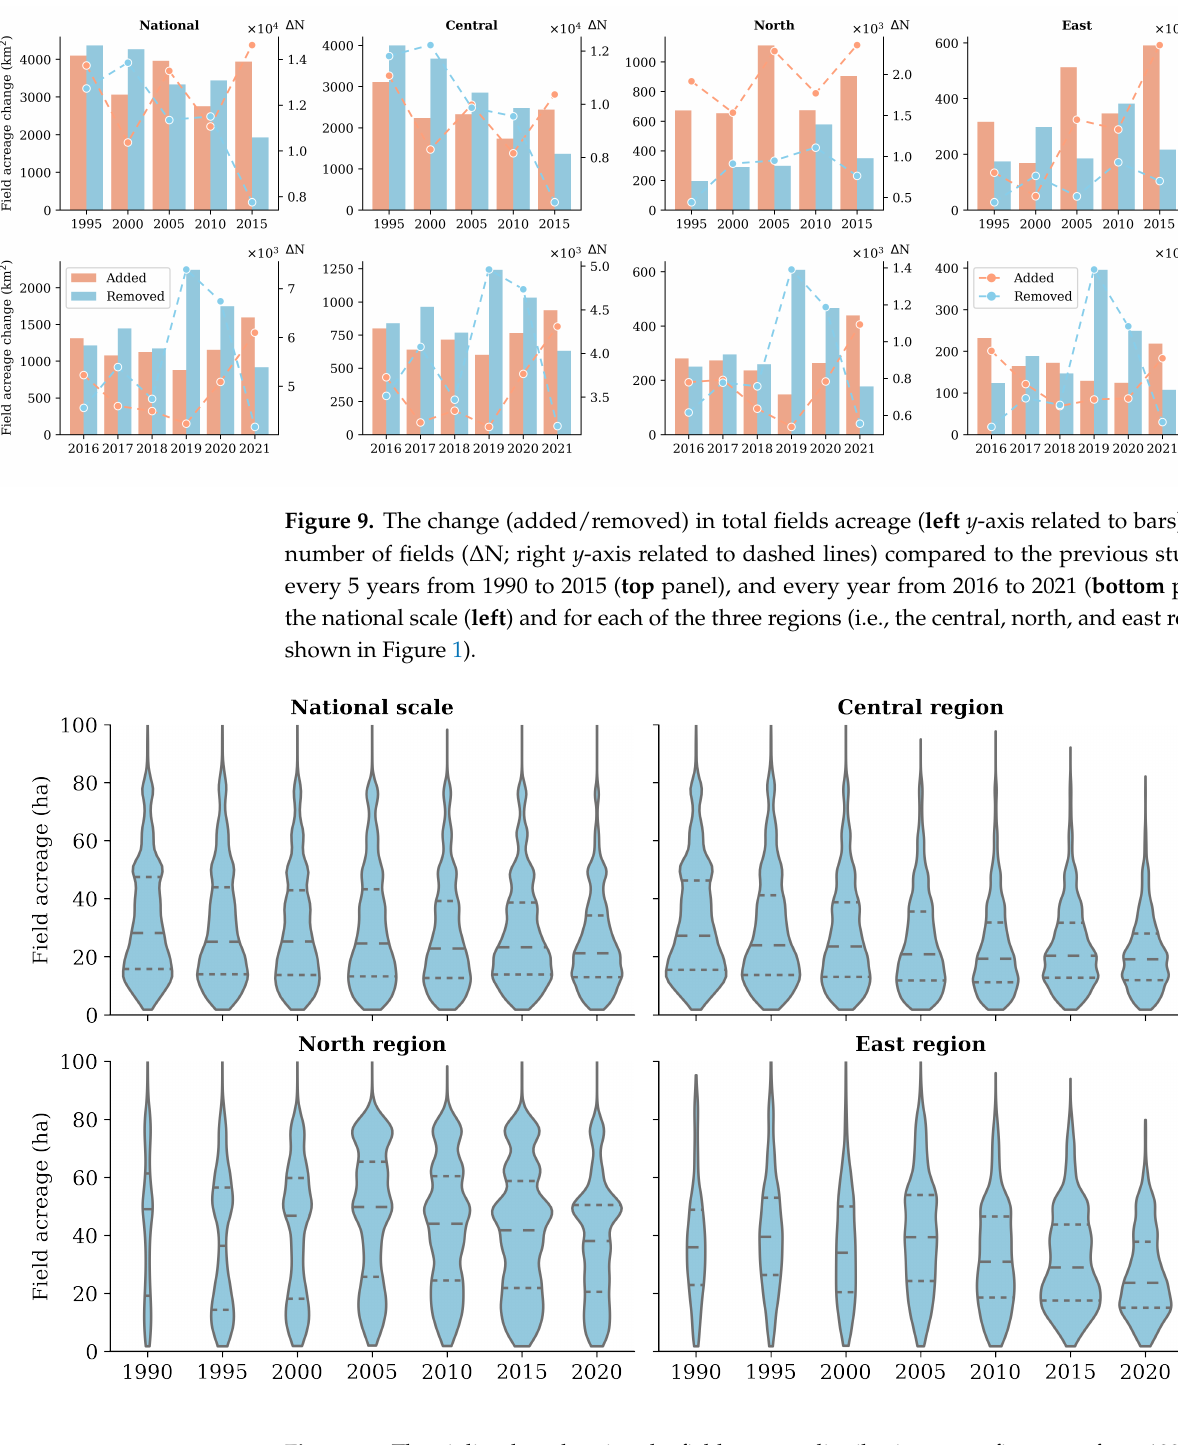
Figure 10. The violin plots showing the field acreage distribution every five years from 1990 to 2020 at the national scale of Saudi Arabia and for the three sub-regions (i.e., the central, north, and east regions as shown in Figure 1). The dashed lines represented